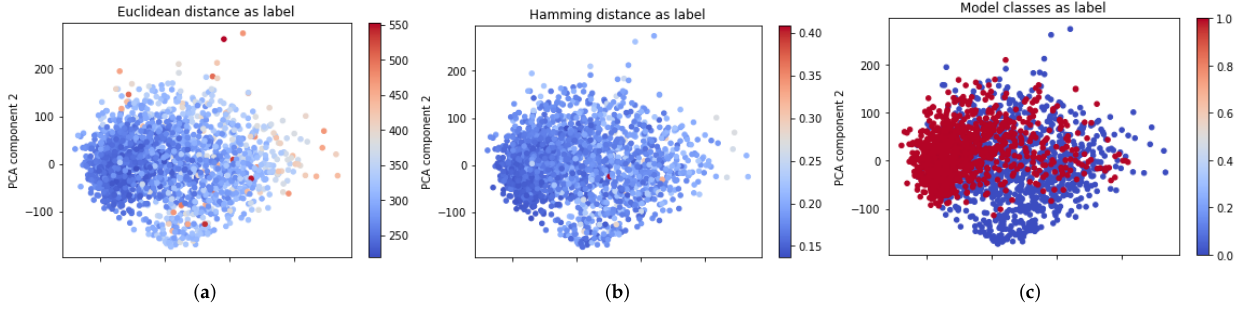
Figure 8. The projection of the feature vectors generated by the PCA algorithm: ( a ) colors the dots using Euclidean distance, while ( b ) colors the dots by Hamming distance. In addition, ( c ) shows how the elements of each class are distributed, where the blue ones are labeled by zero and the red ones are labeled by